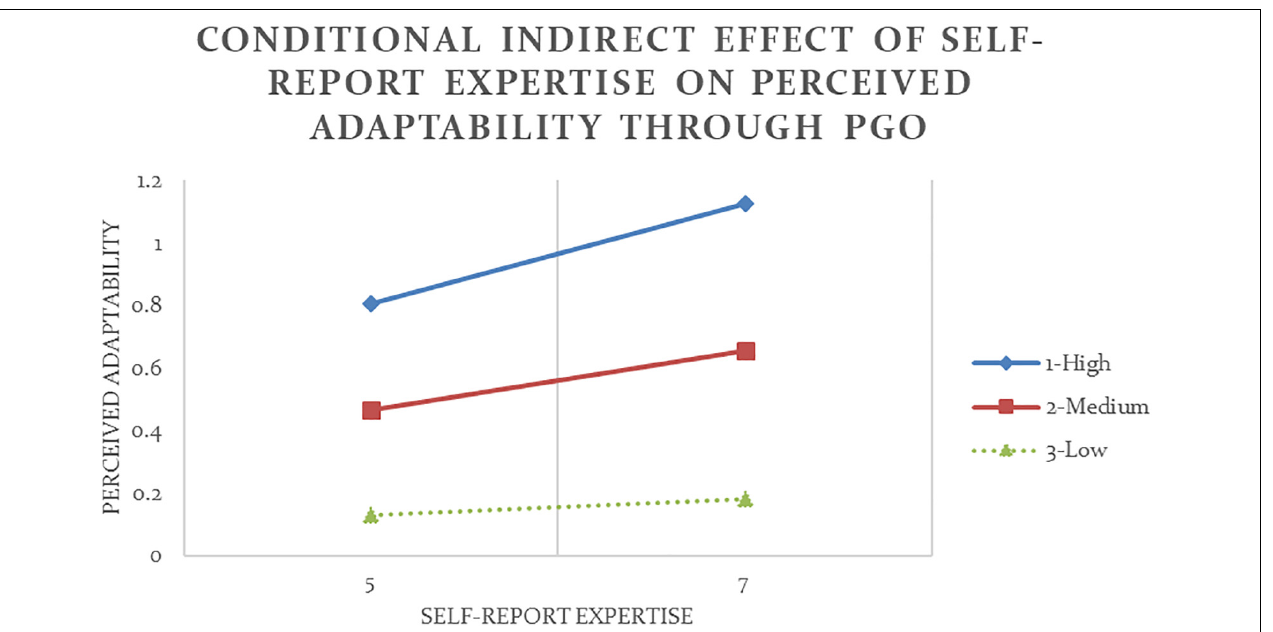
FIGURE 4 | Conditional indirect effect of self-report expertise on other-report adaptability through PGO is significant at medium and high values of the moderator self-report humility with 90% confidence (Analysis